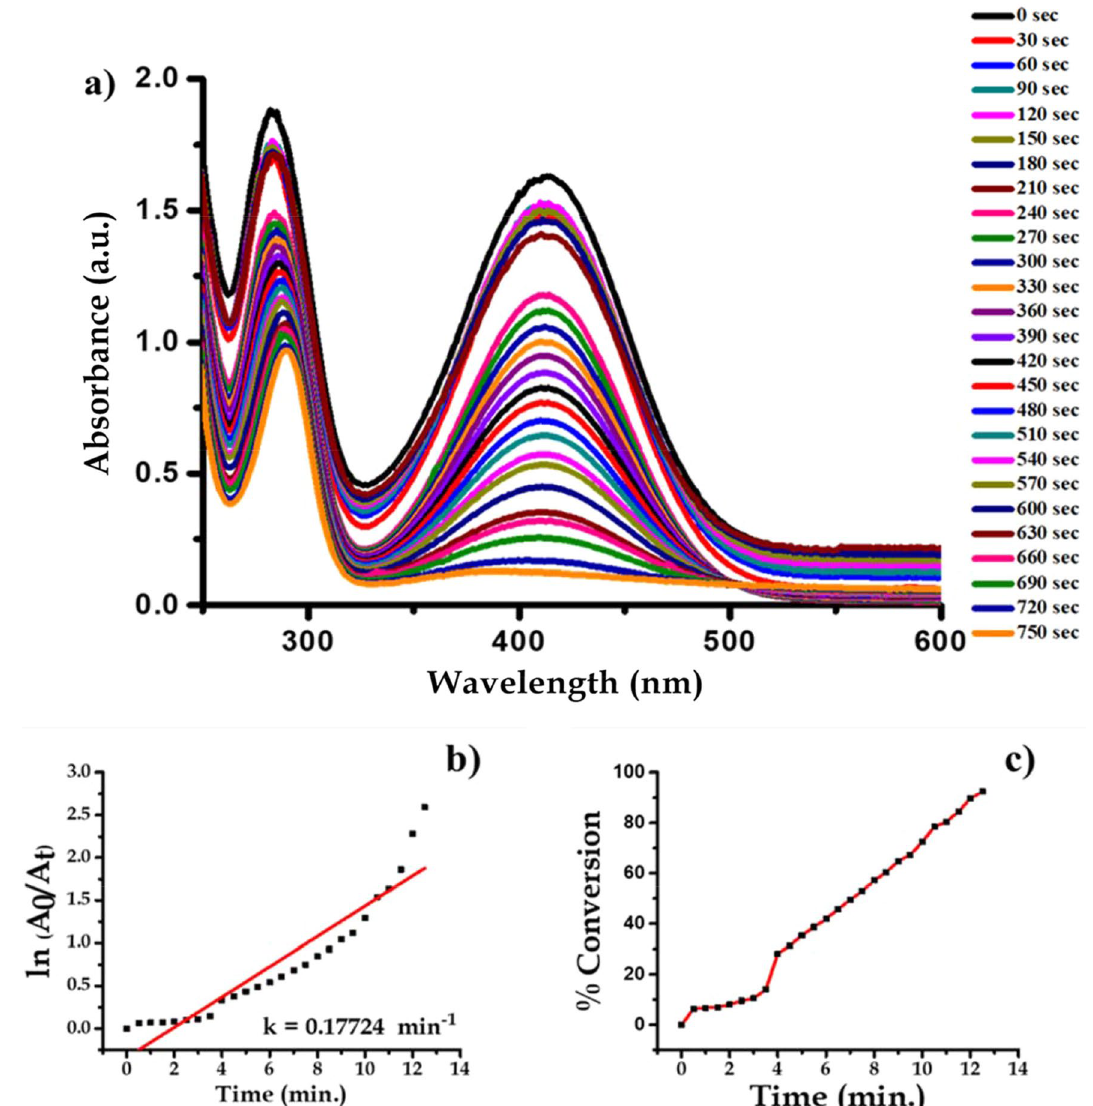
Figure 14. UV–Vis absorption spectra of ( a ) 2-nitroaniline, ( b ) kinetics of catalytic reduction and ( c ) percentage conversion of 2-nitroaniline.